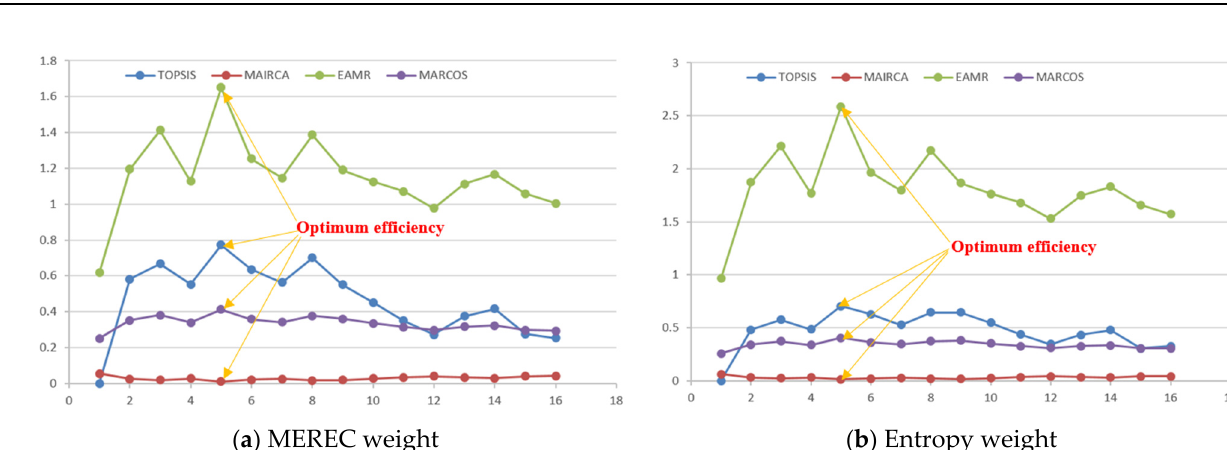
Figure 2. Comparison graph of TOPSIS, MARCOS, EAMR and MAIRCA.